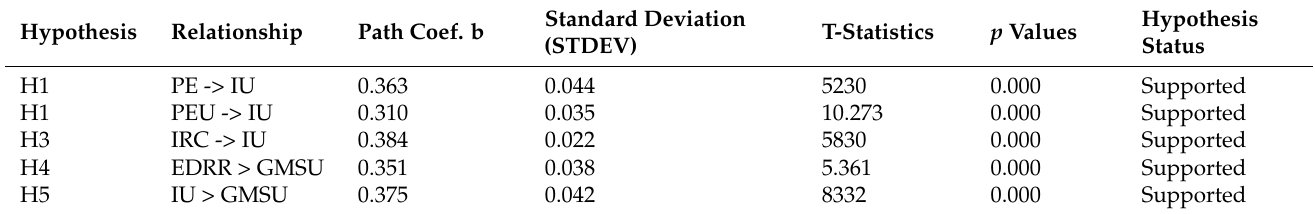
Table 7. Testing the hypotheses in the structural